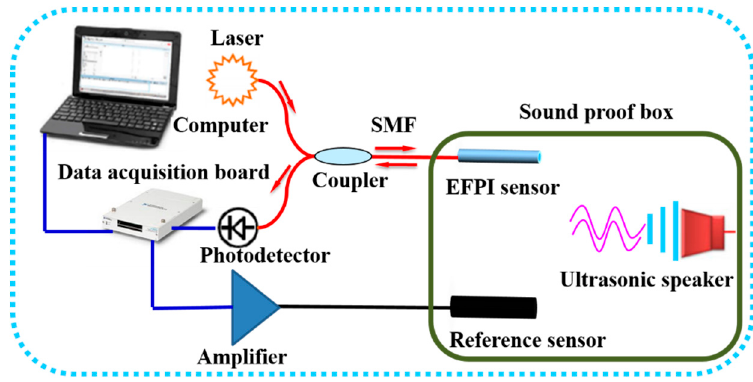
Figure 8. Experimental setup to characterize the fiber optic EFPI sensor system.